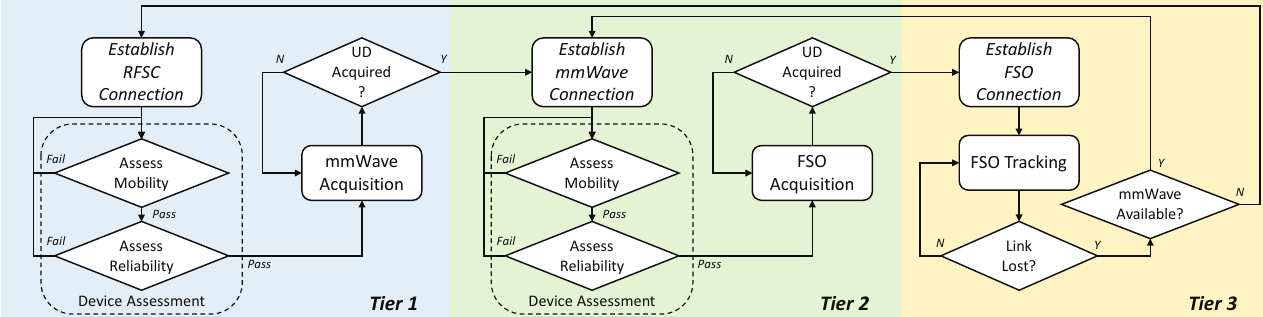
Figure 3. Multi-Tier Heterogeneous (MTH) beam refinement protocol. Device assessment compares UD mobility character- istics and application reliability requirements with next tier characteristics prior to acquiring a higher resolution